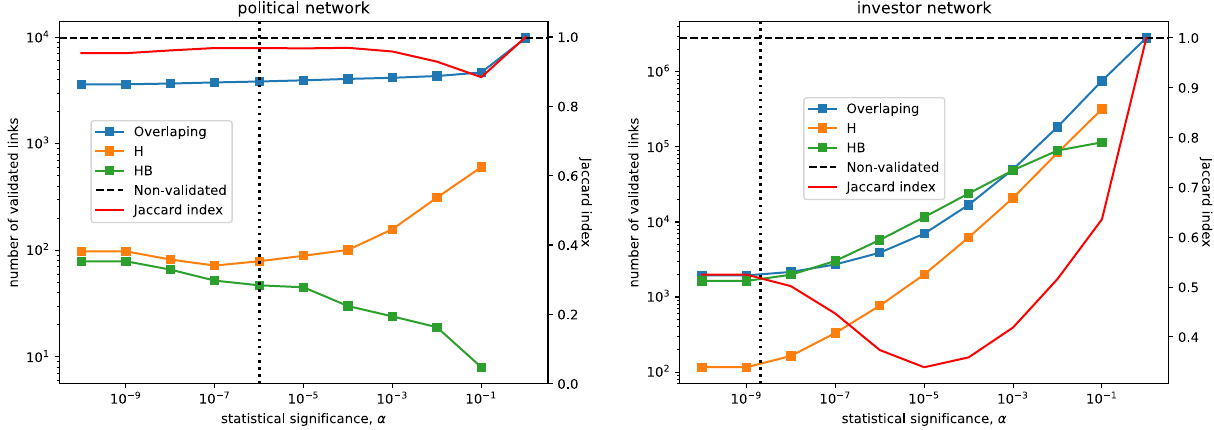
Figure 6. Comparison of empirical networks inferred leveraging our proposed (HB) and the reference (H) null model where the smallest p value obtained over all link types is used when validating a link. The horizontal axis indicates different statistical thresholds used in link validation. The left-hand side figure shows the comparison of the political networks. The right-hand side figure shows the comparison of the investor